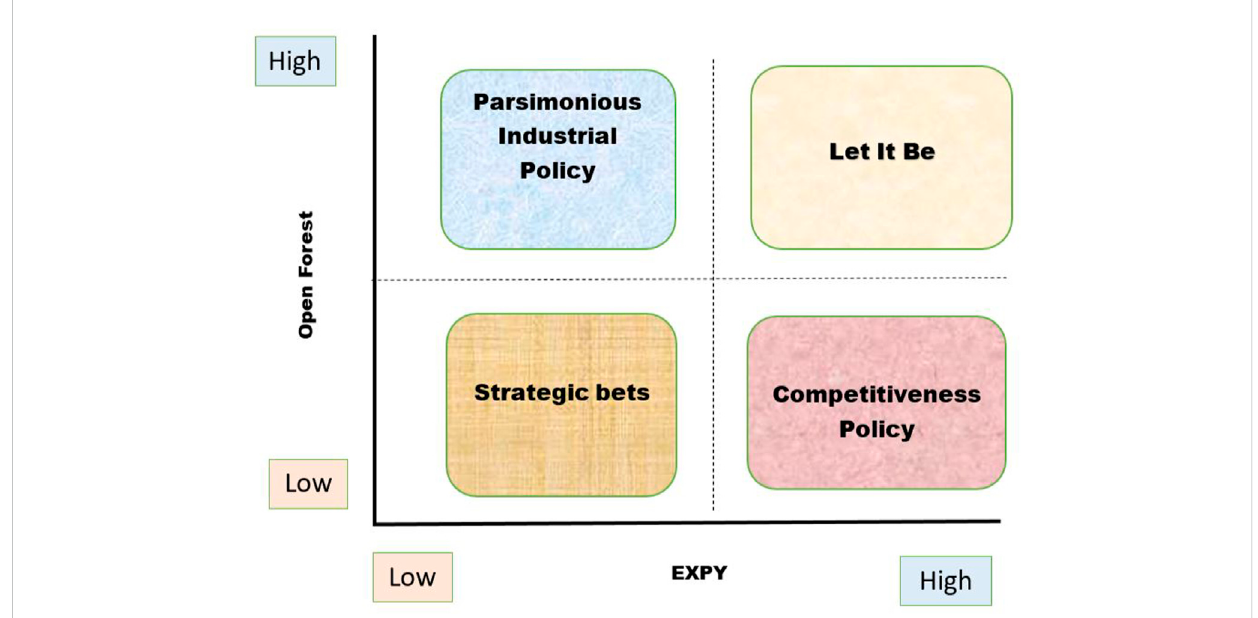
FIGURE 4 Policy Map Diagram for Future Industrialization and export diversi fi cation.